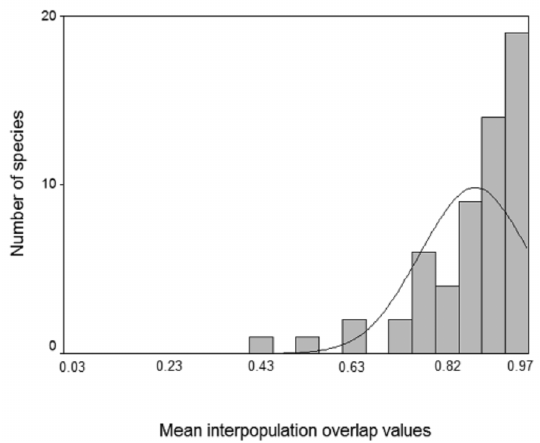
Fig. 1. Distribution of the number of snake species in terms of their interpopulation diet overlap values (calculated by Pianka’s formula; all snake families included) as regards the general affini- ty criterion. The line indicates the normal curve. Note that the great majority of the species are distributed in the very high over- lap values intervals (mean ± SD = 0.885 ± 0.117, n =